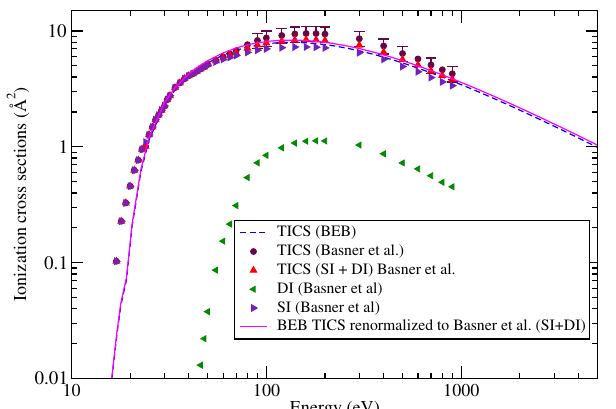
Figure 1. Total ionization cross sections of WF 6 : dashed curve, BEB; circles, Basner et al. [21]; triangles, sum of SI and DI ions from Basner et al. [21]; left triangles, summed PICS of DI cations from Basner et al. [21]; right triangles, summed PICS of SI cations from Basner et al. [21]; line curve, renormalized BEB